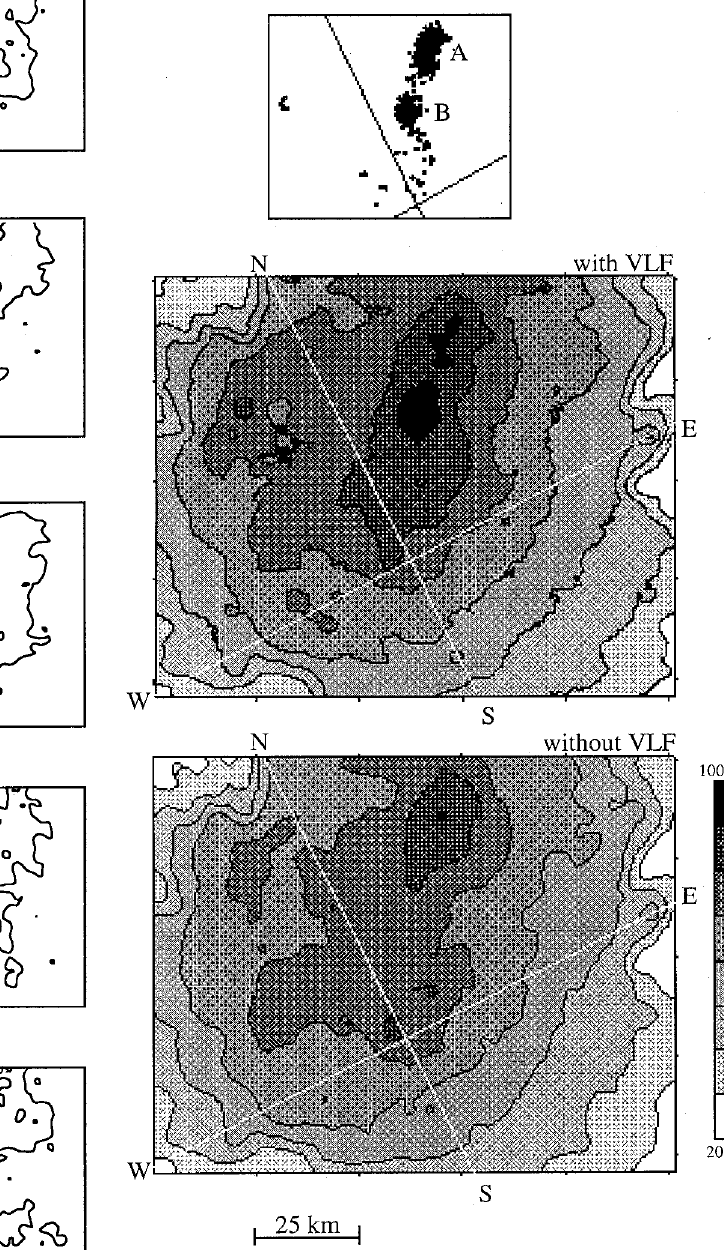
Fig. 3. The uppermost panel presents the spatial distribution of luminosity maxima. The two lower panels represent the distribution of summarized intensity over the whole digitized area for the time intervals when the ELF-VLF emissions occurred (the middle panel ) and when they were absent (the lowest panel ). The integration times were: 01.31:00-:05; 01.31:09-:18; 01.31:22-:25 UT for the middle panel and 01.31:05-:09; 01.31:18-:22; 01.31:25-:30 UT for the bottom